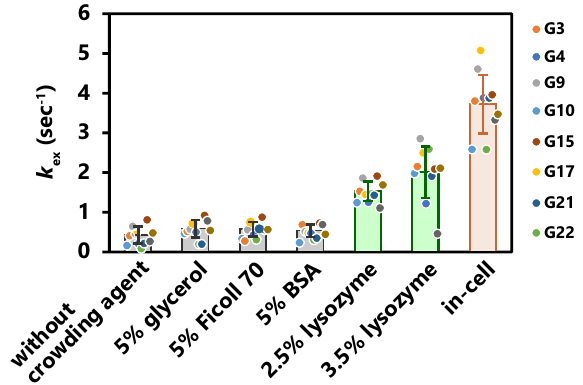
Fig. 5 | Analysis of the exchange of imino protons of the DNA GQ structure in the presence of crowding agents. The k ex values of each guanine in teloDNA (excludingG5andG23)wereobtainedunderinvitroconditionsintheabsenceand presenceof a crowding agent (glycerol,Ficoll,BSA, and lysozyme)at300mMTris. The k ex valuesat300mMTriscanberegardedtobeequalto k open underindividual invitroconditions(seetextfordetails).Theintensityofiminoprotonwasobtained foreachresidue( n =1).Standarddeviationofthenoisesignalfortheregionof1D 1 H spectrum in which no signal is present was calculated and used as error bars of intensities.Themeanofthe k ex valueswasobtainedfrom50datasetsofintensities constructed by Monte Carlo simulation using the error bars of intensities for each residue. The obtained means were averaged over residues under individual con- ditions. The averaged k ex values under individualinvitroand in-cellconditions are indicated. The error bars are the standard deviation. Source data are provided asa Source Data fi